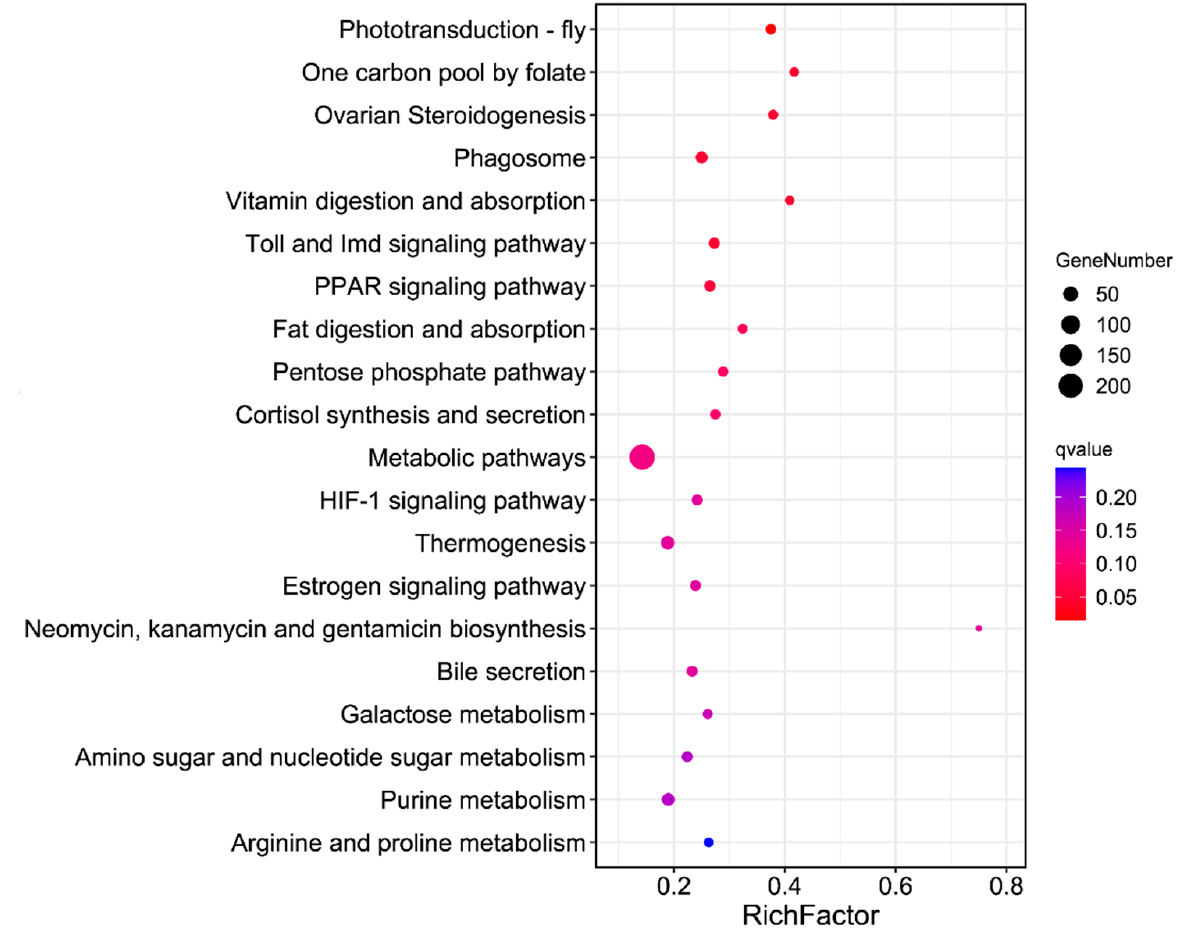
Figure 4. Top 20 of the KEGG enrichment of DEGs in LW-13 compared with G88. 3.5. Influences of LW-Opsin Mutation on the Expression of Genes in the Phototransduction